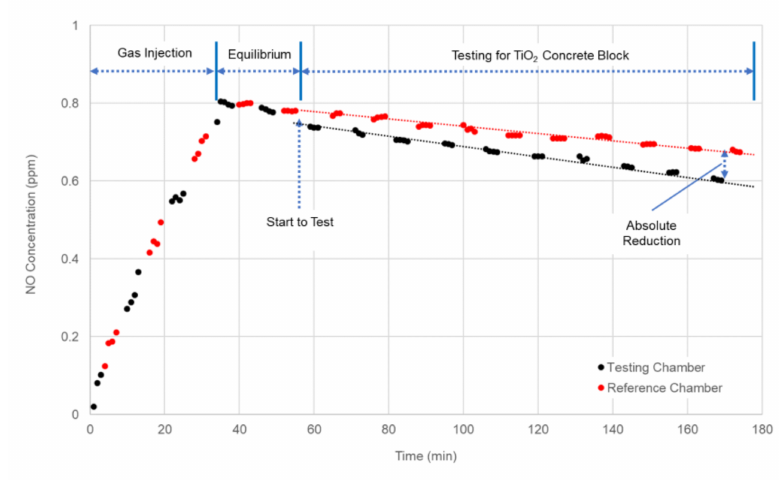
Figure 11. Variation of NO concentrations during the experiment.